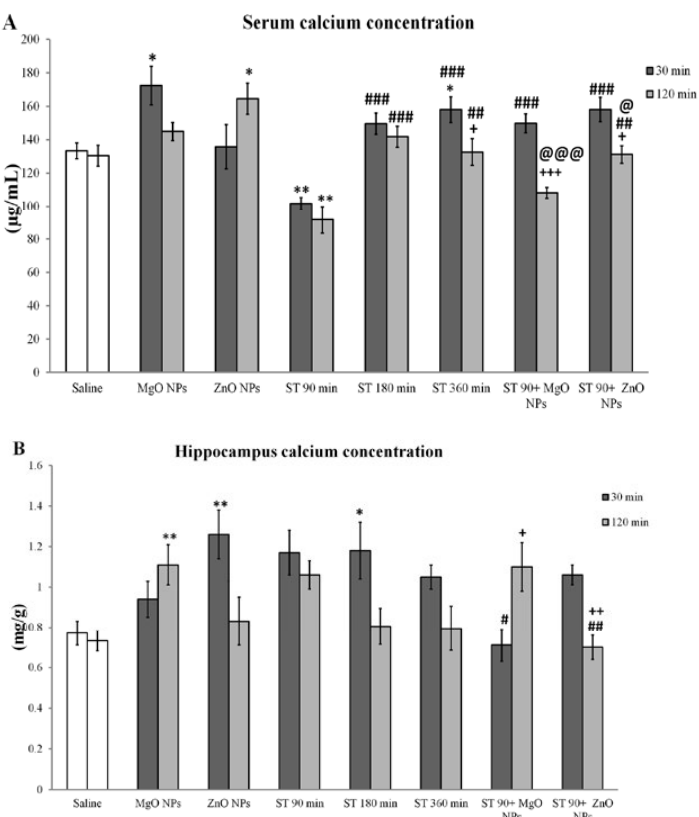
Fig. 5. Assessment of Ca 2+ concentration. *P<0.05 and **P<0.01 are differences in comparison with the control group at the same time (30 and 120 min). +P<0.05, ++P<0.01 and +++P<0.001 are differences between equal treatment groups in two different times. #P<0.05, ##P<0.01and ###P<0.001 are differences in comparison with ST 90 min groups at the same time (30 and 120 min). @P<0.05 and @@@P<0.001 are differences in comparison with MgO NPs or ZnO NPs groups at the same time. All bars are means ± standard error of the means.